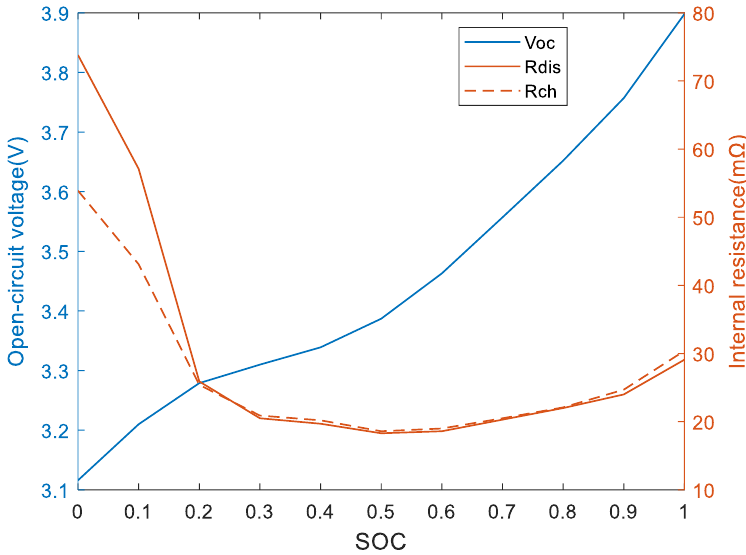
Figure 3. Open circuit voltage and internal resistance with state of charge.